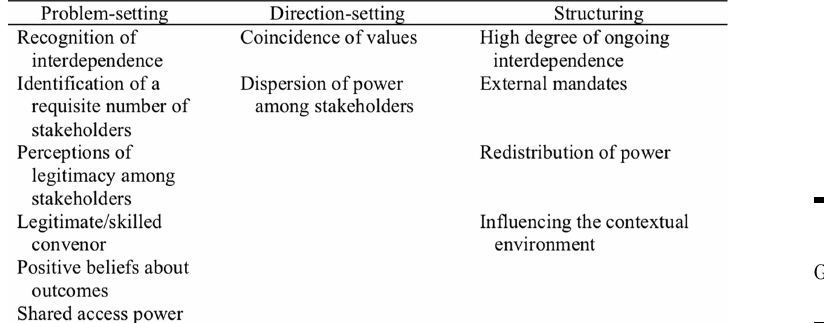
Figure 1. Gray ’ s 1985